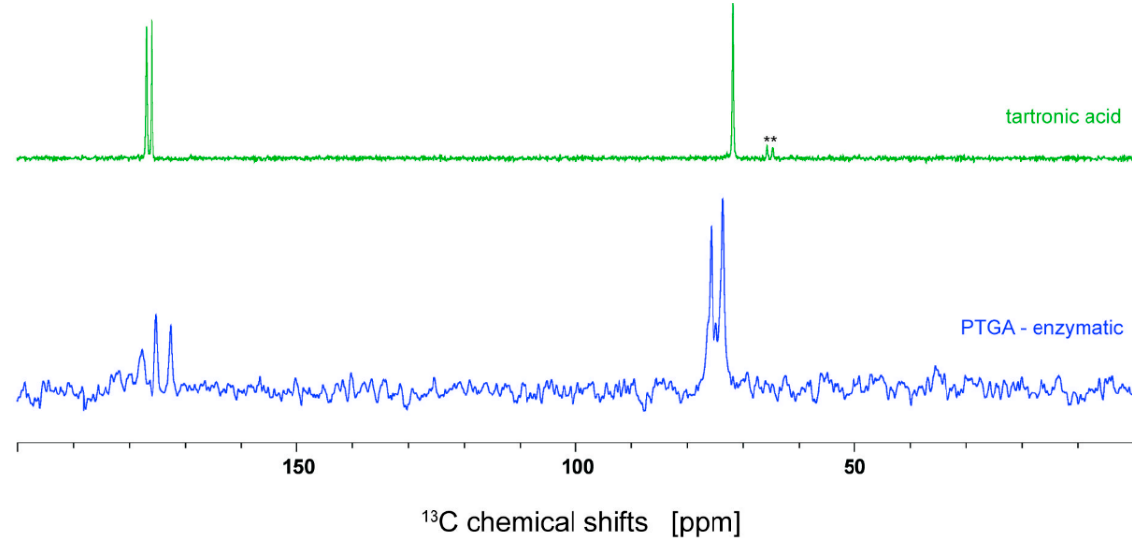
Figure 2. 13 C ss-NMR spectra of tartronic acid ( TA ) (solid green line) and PTGA_Enz (solid blue line). The asterisks indicate sidebands.